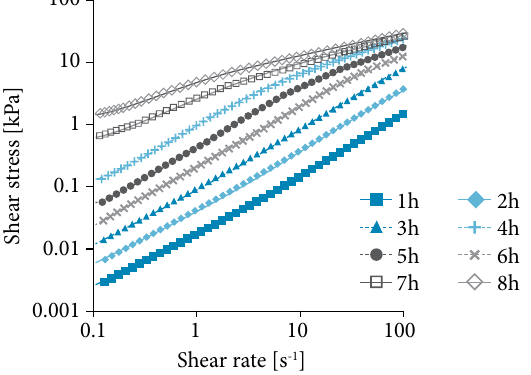
Figure 1. Variation in shear-stress of the liner with